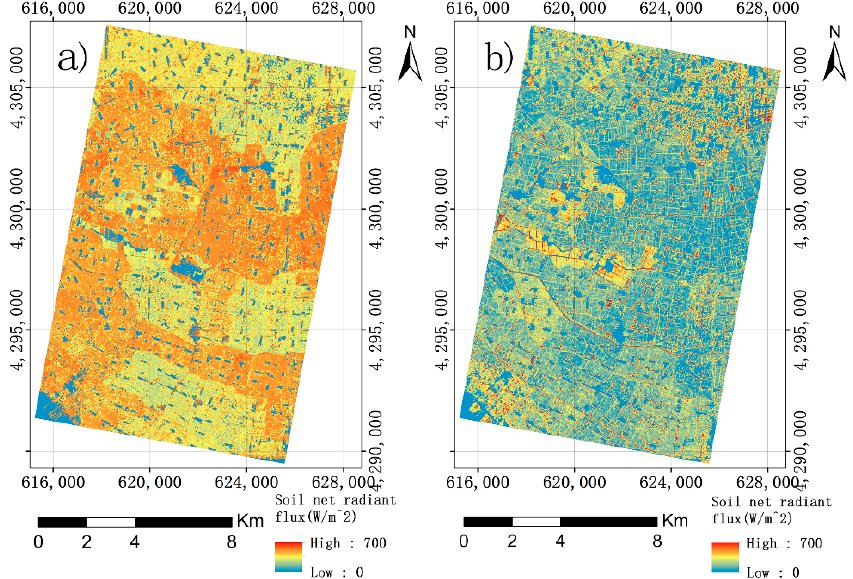
Figure 11. Spatial distribution of the soil net radiant flux using: ( a ) the June 4 th image and ( b ) the July 10 th image 2008, respectively.